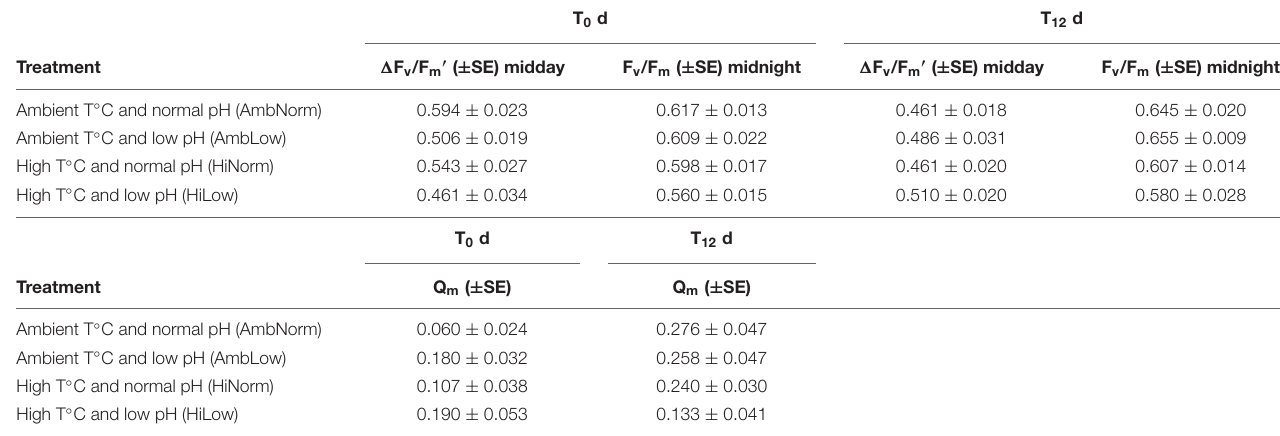
TABLE 1 | Values for the quantum yield of PSII fluorescence and the excitation pressure (Q m ) over PSII at the beginning (T 0 ) and end (T 12 ) of the experiment.